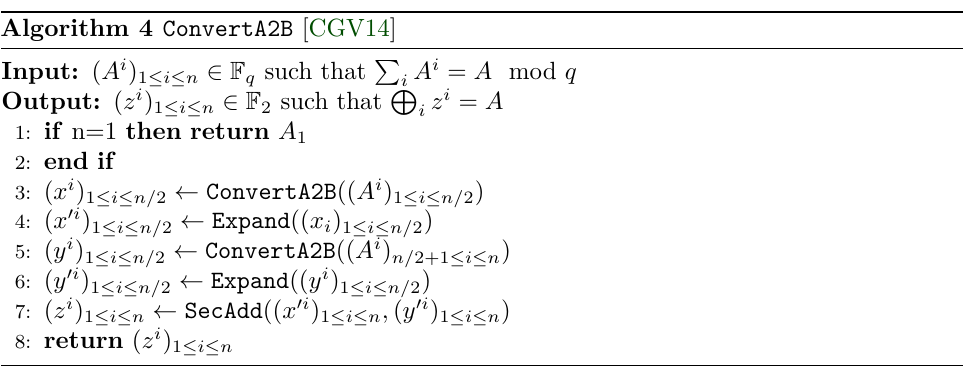
Algorithm 4 ConvertA2B